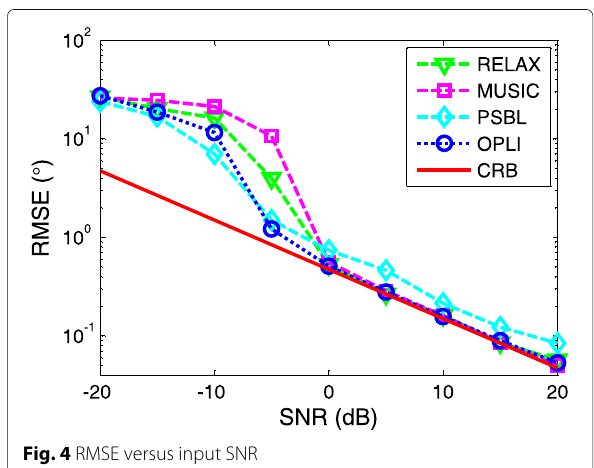
Fig. 4 RMSE versus input SNR